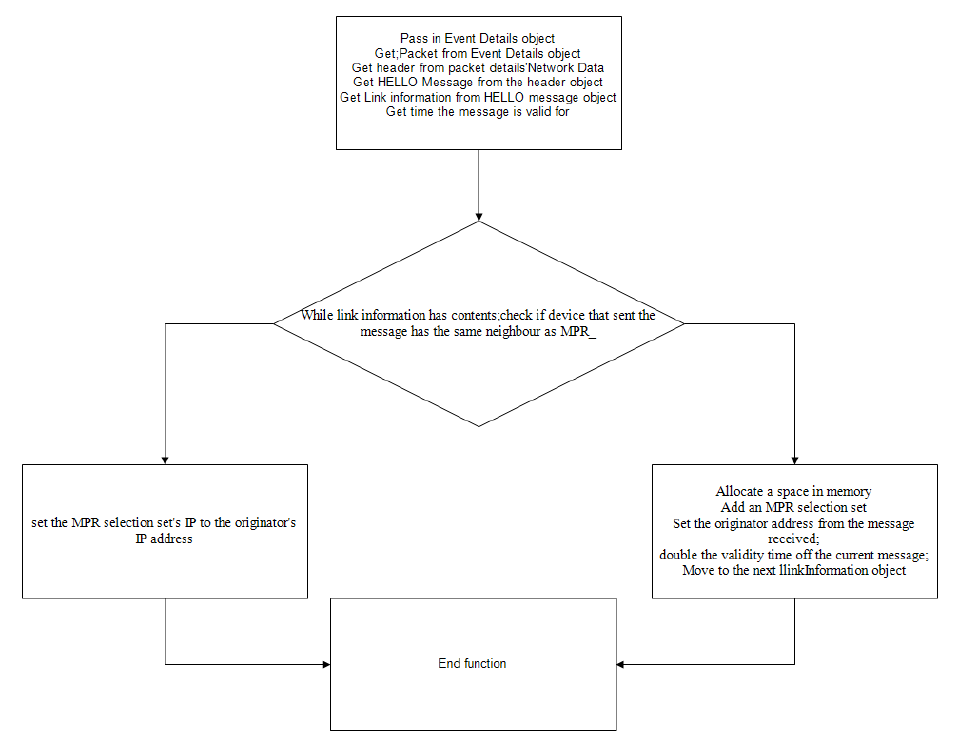
Figure 5. Malicious node infiltrating MPRs.